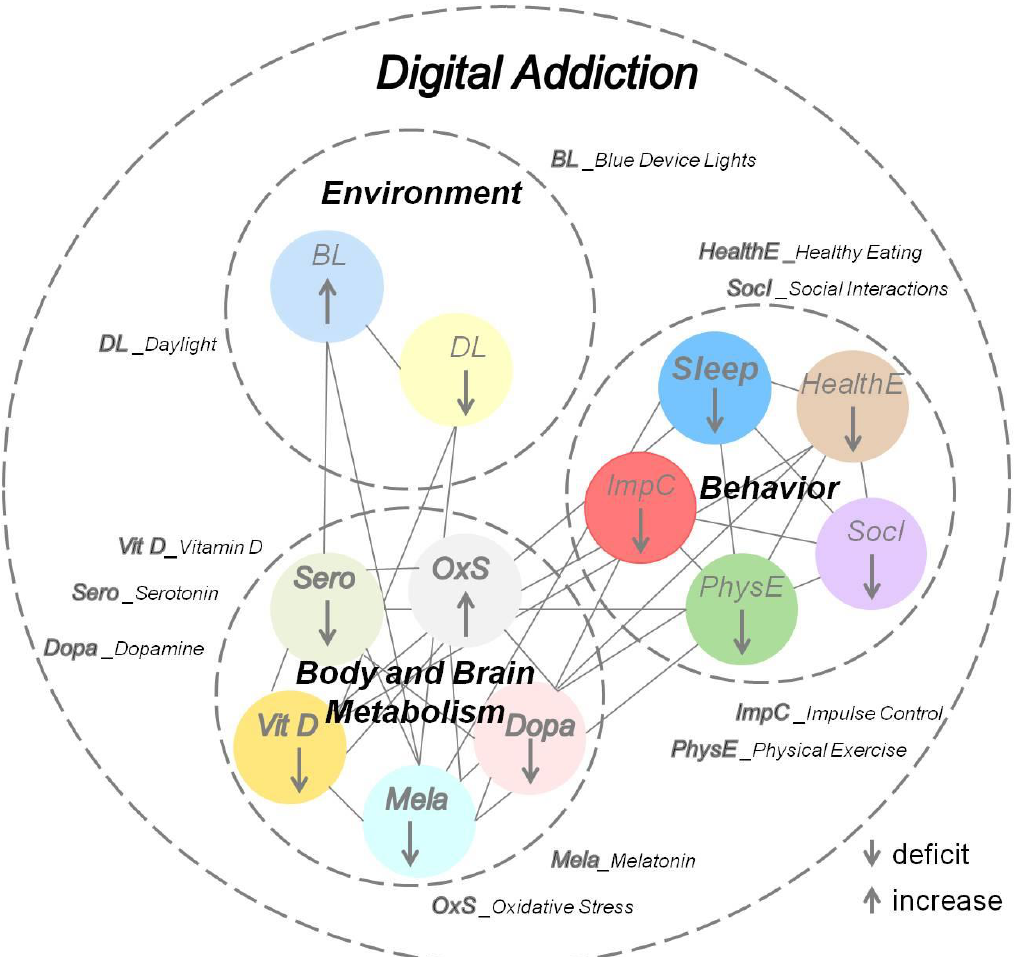
Figure 2. Sleep dysfunction in digital addiction is identified as the key part of a set of mutually reinforcing behaviors. These are the consequences of a perturbed brain – body metabolism, con- trolled by complex chains of functionally interdependent mechanisms triggered by internal (pre- disposition, sensitivity) and environmental